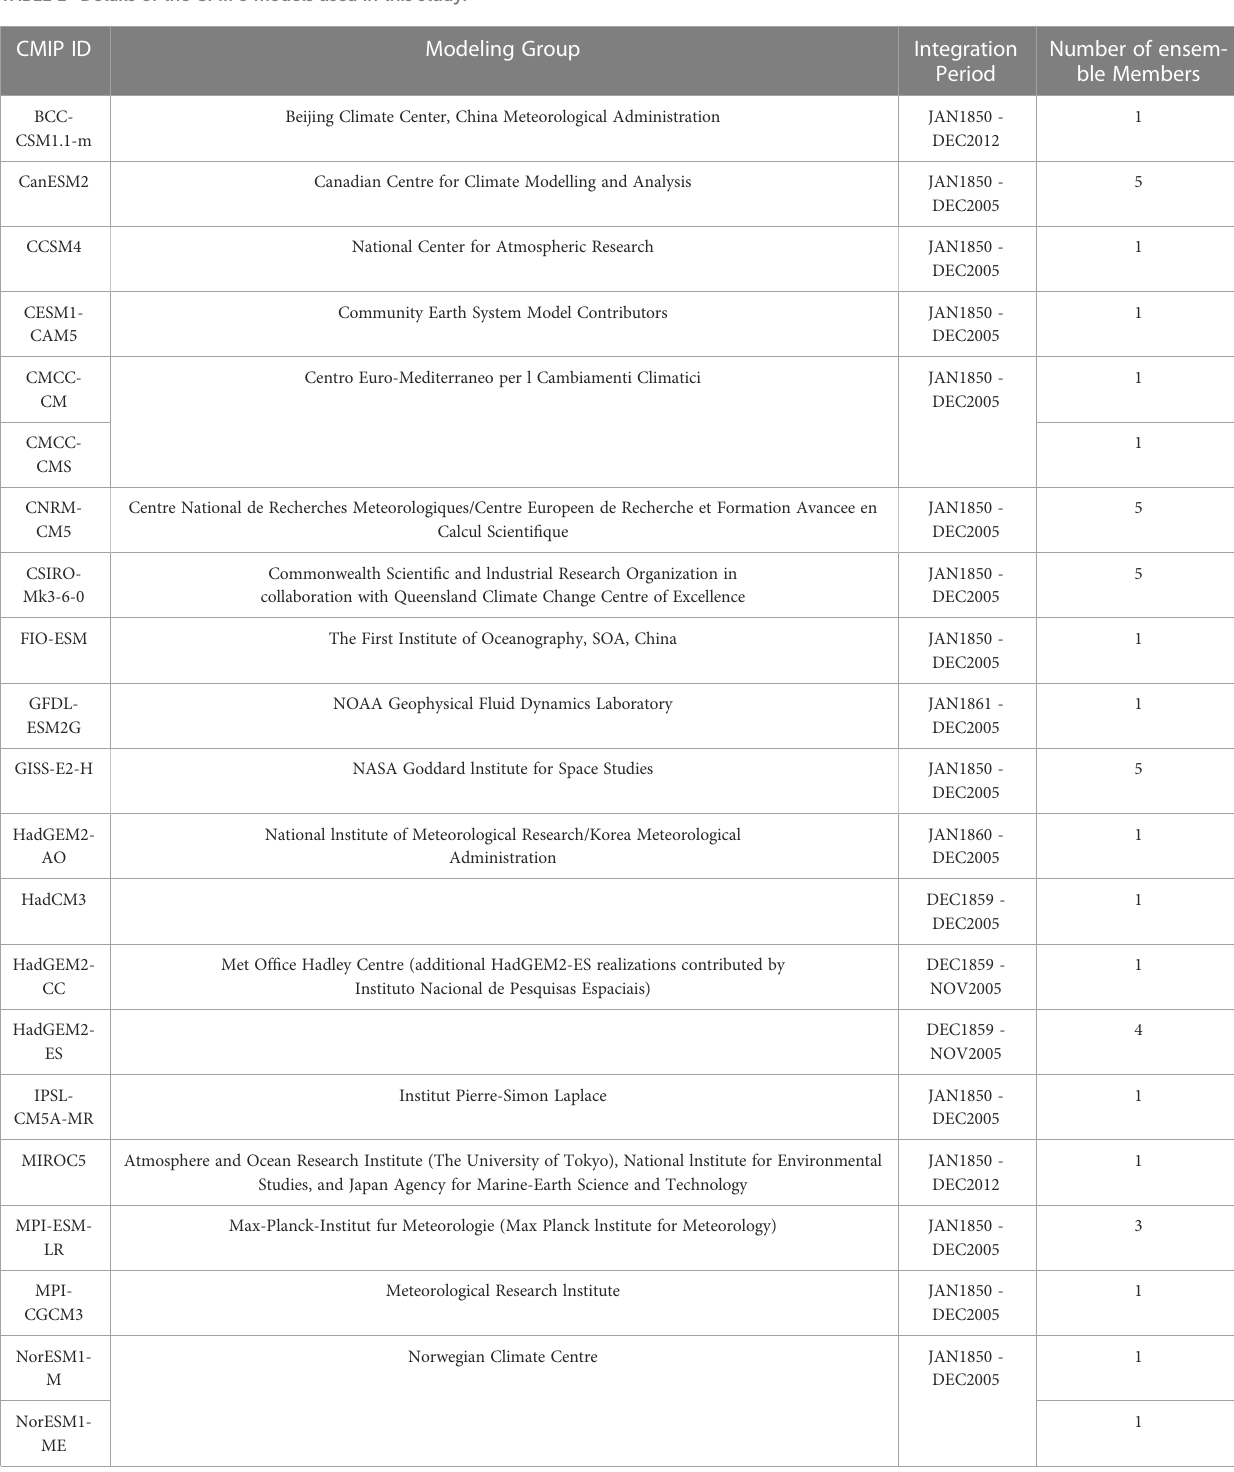
TABLE 1 Details of the CMIP5 models used in this